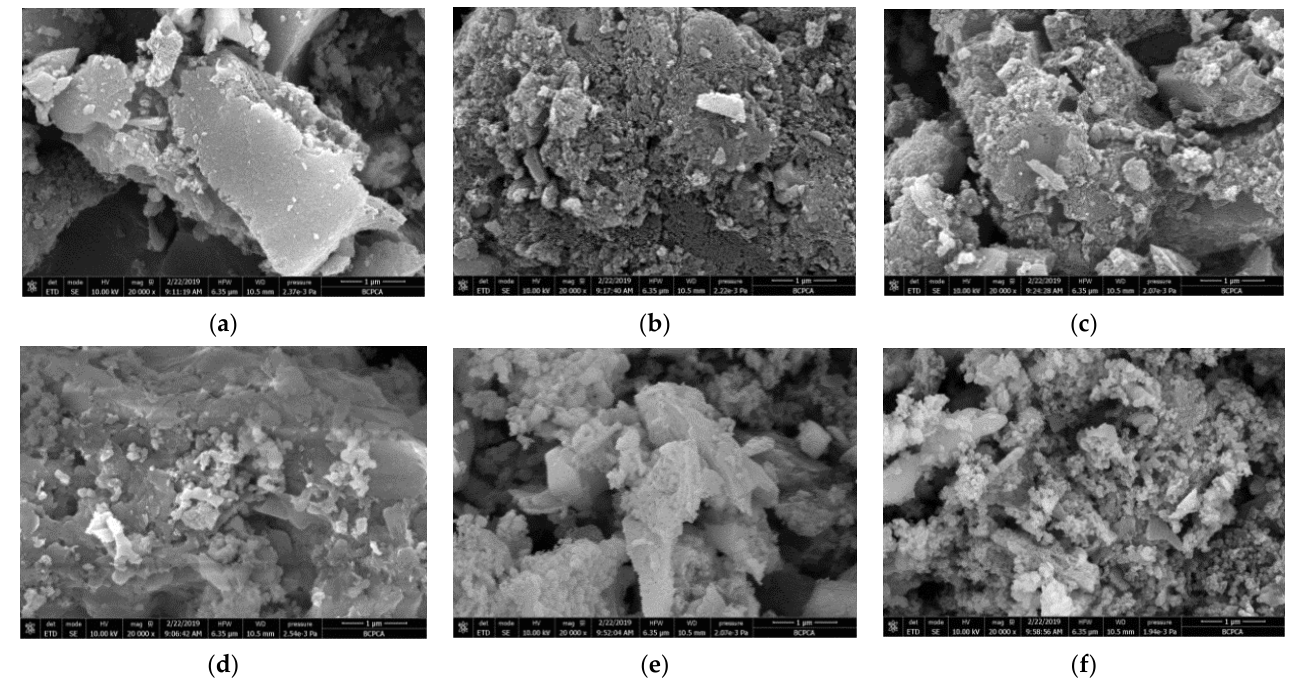
Figure 7. SEM images of the plant ash particles after different treatments: ( a ) before ADS of nitrate; ( b ) after ADS of nitrate; ( c ) after DEP of nitrate; ( d ) before ADS of phosphate; ( e ) after ADS of phosphate; and ( f ) after DEP of phosphate.